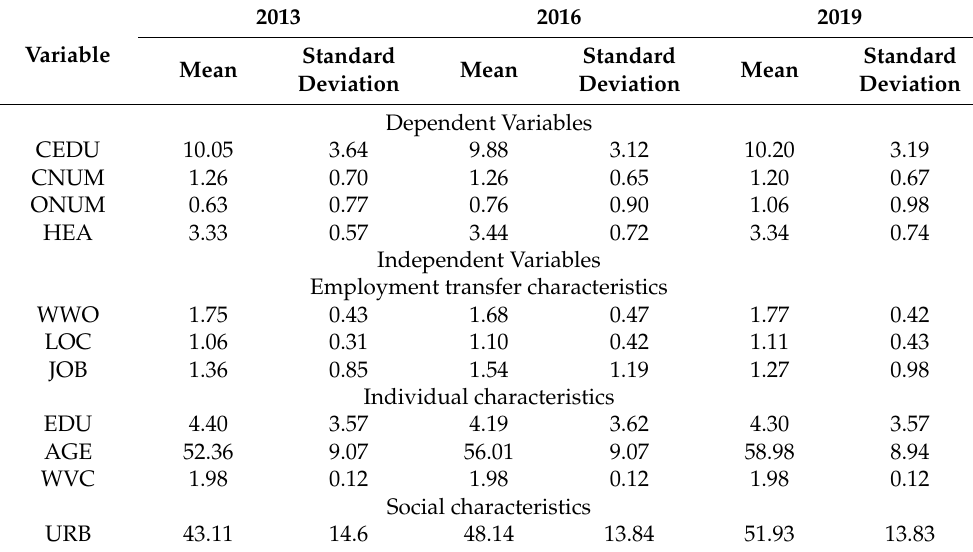
Table 3. Descriptive statistical results of panel